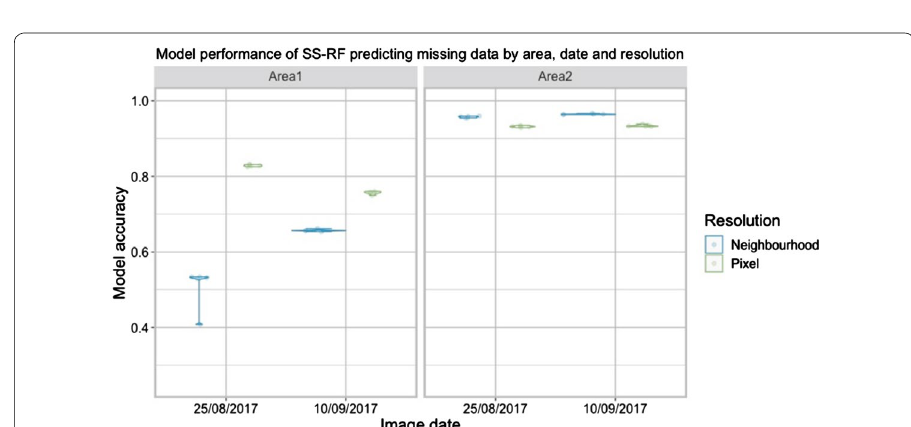
Fig. 9 Model performance interpolating land cover class for two areas on 25 August 2017 and 10 September 2017 at pixel and neighbourhood scale. Neighbourhood resolution results are in blue and pixel resolution results are in